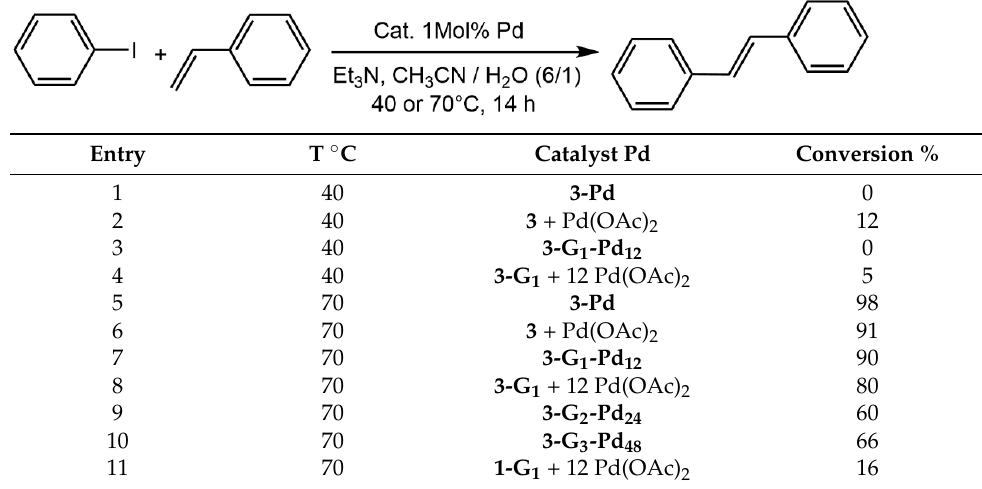
Table 1. Catalysis of Heck couplings between iodobenzene and styrene.